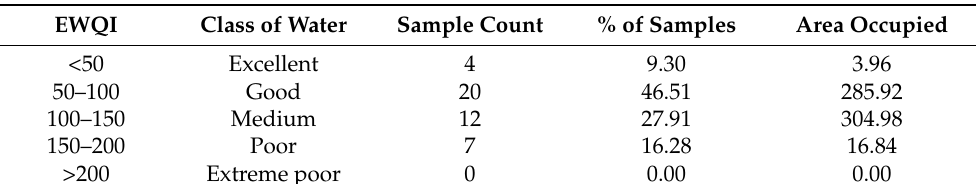
Table 2. Entropy water quality index in the study area.